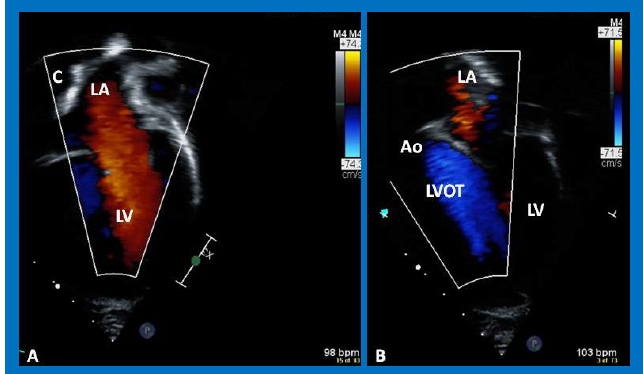
Figure 41. Selected video frames from an apical views demonstrating laminar flow from the left atrium (LA) to the left ventricle (LV) ( A ) and from the LV to aorta (Ao) ( B ). Note laminar flow in the LV outflow tract (LVOT) ( B ). Medial portion of the conduit (C) is seen in ( A ).